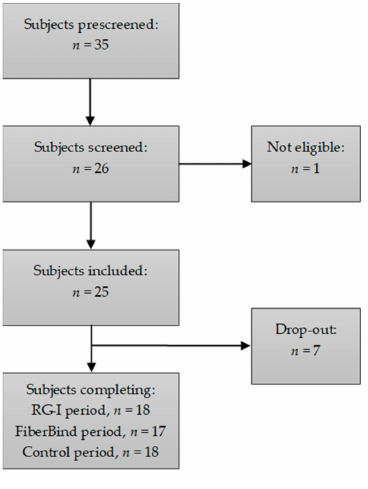
Figure 2. Subject flow chart. Table 3. Subject characteristics at